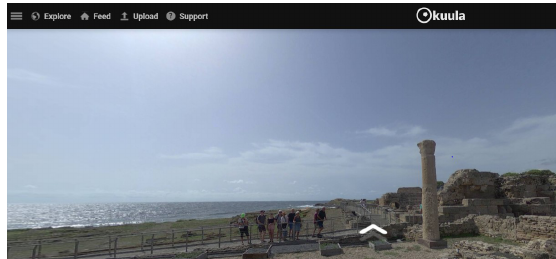
Figure 13. Viewing spot not accessible to tourists.